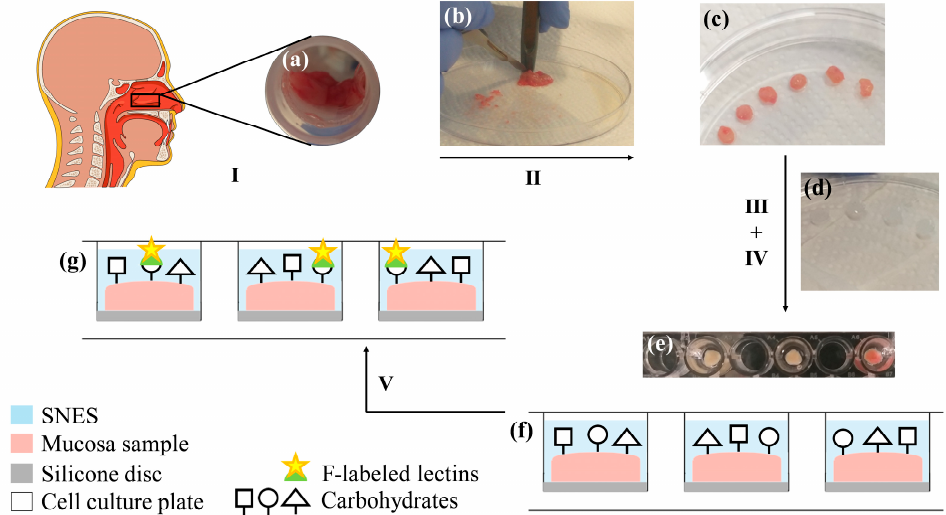
Figure 1. Experimental setup for human nasal ex vivo samples. I. Collection of healthy human nasal mucosa tissue ( a ) during routine turbinoplasty surgery. II. Using a punch and scalpel ( b ) samples are cut into round pieces of 5 mm in diameter ( c ). III. Specimens are fixed on a silicone disc ( d ) with the mucosal side facing upward, using acrylic glue. IV. Sample discs are placed into the well of a 96-well cell culture plate and attached to the bottom with acrylic glue. To prevent fluorescent probes in neighboring wells from mutually interfering with their fluorometric measurements, every other well is left empty ( e ). The sample surface is covered with simulated nasal electrolyte solution (SNES) ( e , f ). V. Samples are incubated with fluorescein (F)-labeled lectins to elucidate the glycosylation pattern and the lectin binding capacities of the healthy human nasal mucosa ( g ).